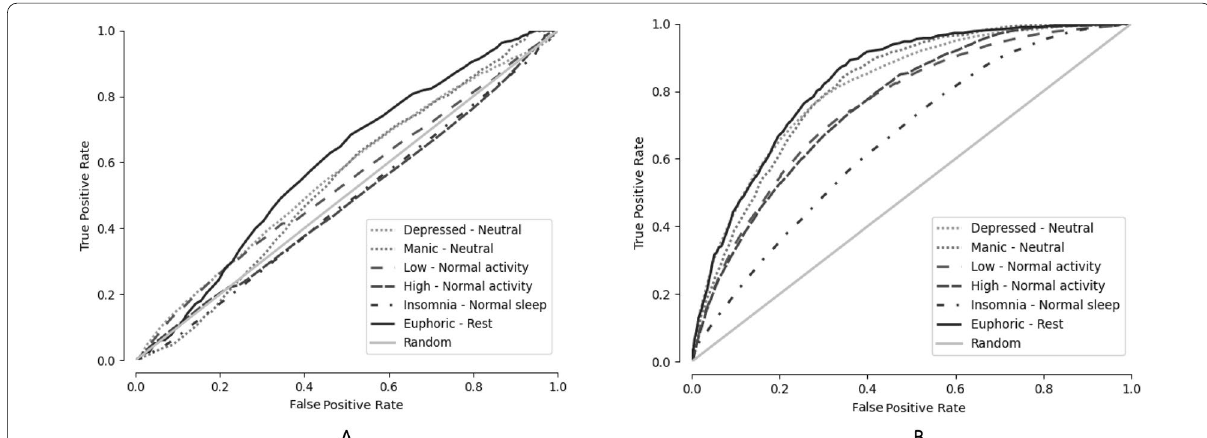
Fig. 3 The ROC curve for the classifications of different states based on voice features in patients with bipolar disorder. A The user‑independent models; B the user‑dependent models. Euphoric defined as combined increased mood and increased